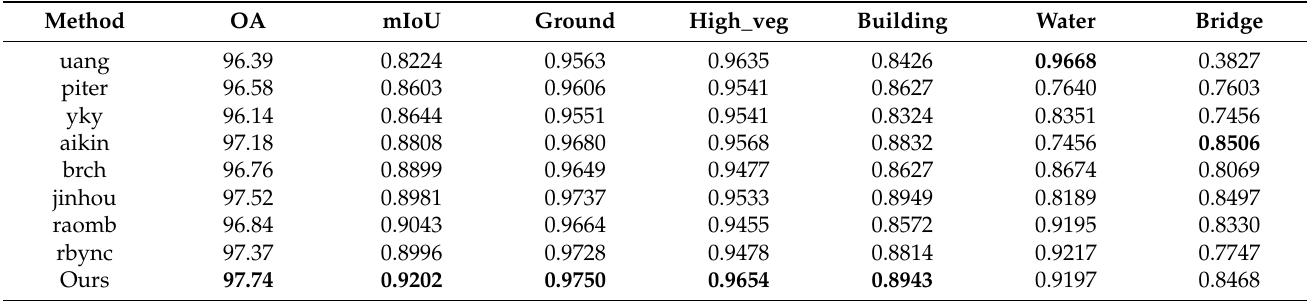
Table 7. Quantitative comparison of performance between our method and other methods on the DFC 3D dataset. The highest scores are typed in bold.